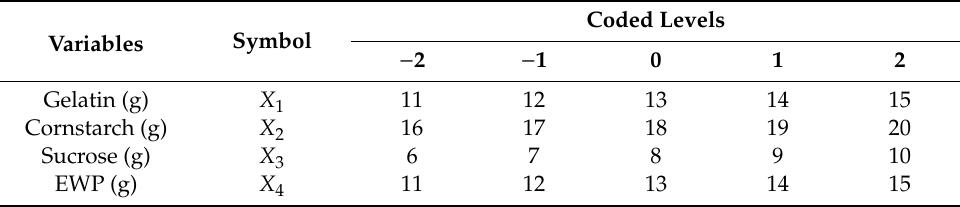
Table A1. Independent variables and their levels used in the response surface design.